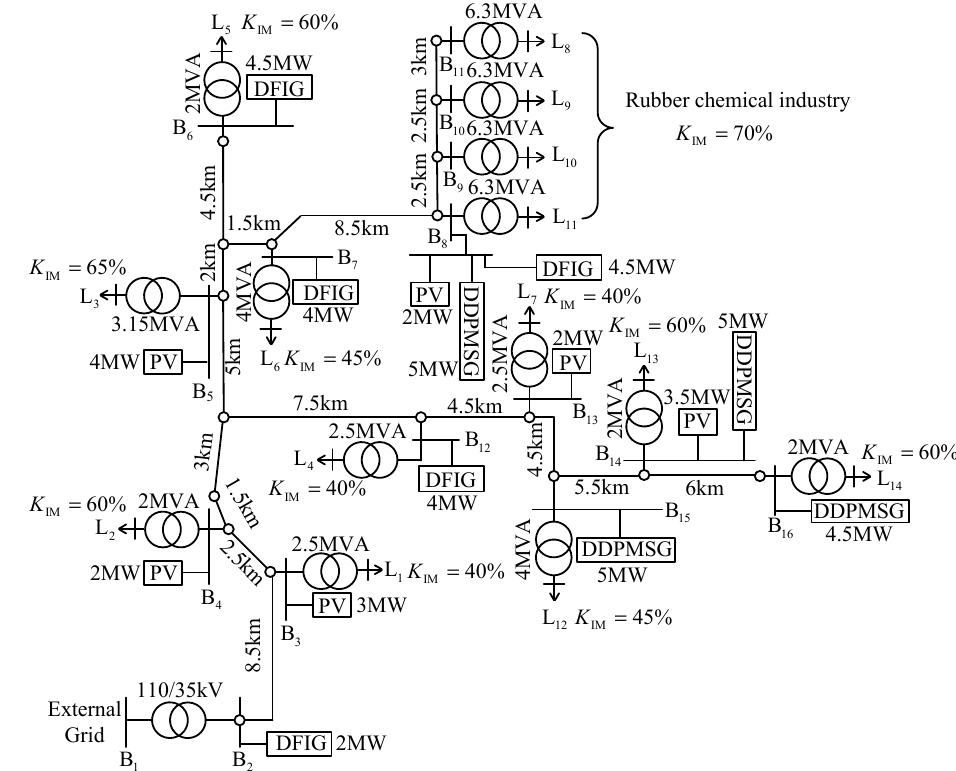
Figure 9. Structure of a real 35 kV ADN.